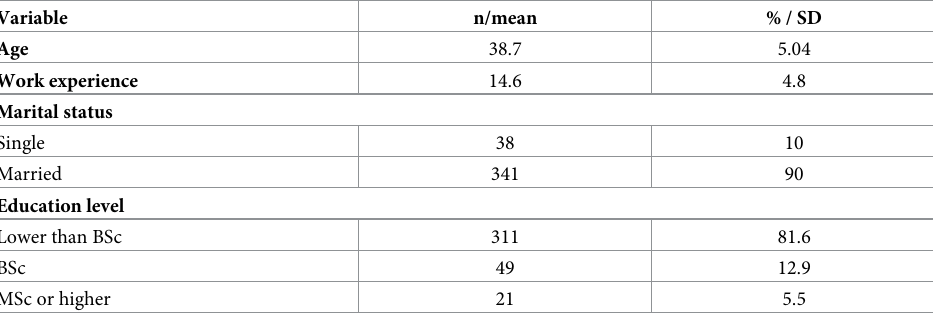
Table 1. Selected socio-demographic, and job characteristics of the